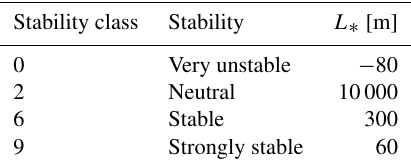
Table 3. Selected atmospheric stability classes from Meteodyn WT (Meteodyn, 2014).